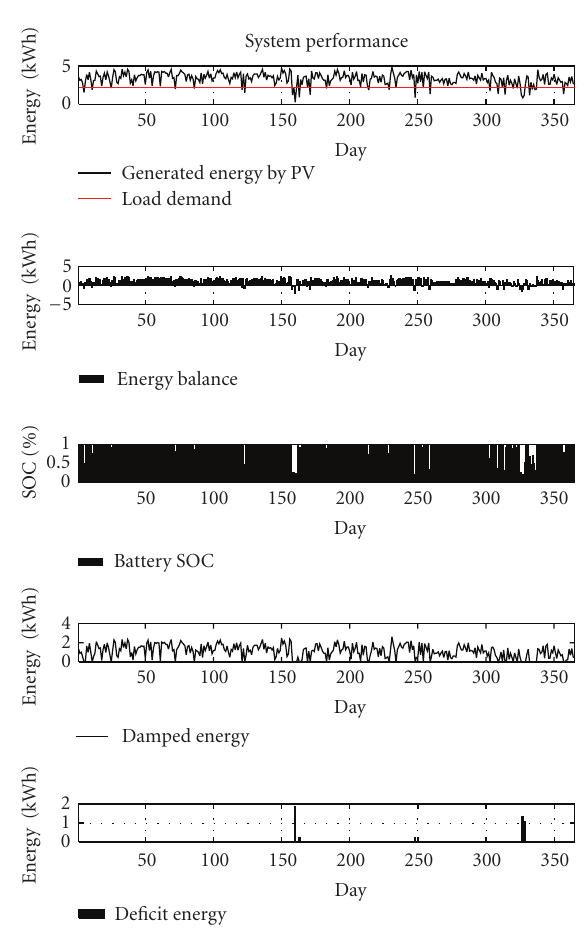
Figure 12: Designed PV system performance for a period of one